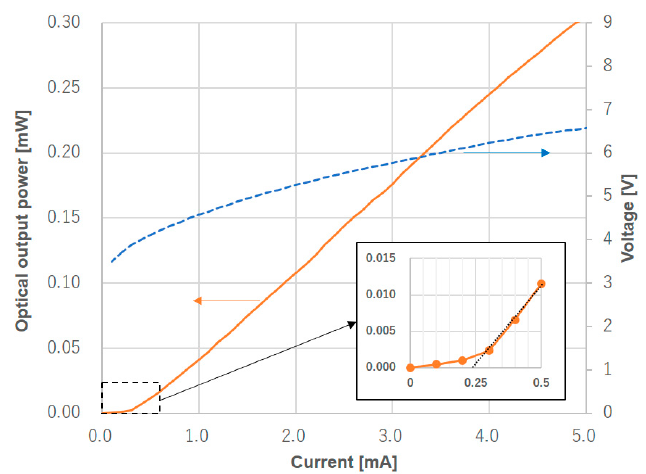
Figure 8. I-V and I-L curves obtained from a GaN-VCSEL with a 3 μ m aperture at room temperature in response to continuous current injection. The inset shows an enlarged view of the data around the threshold current.